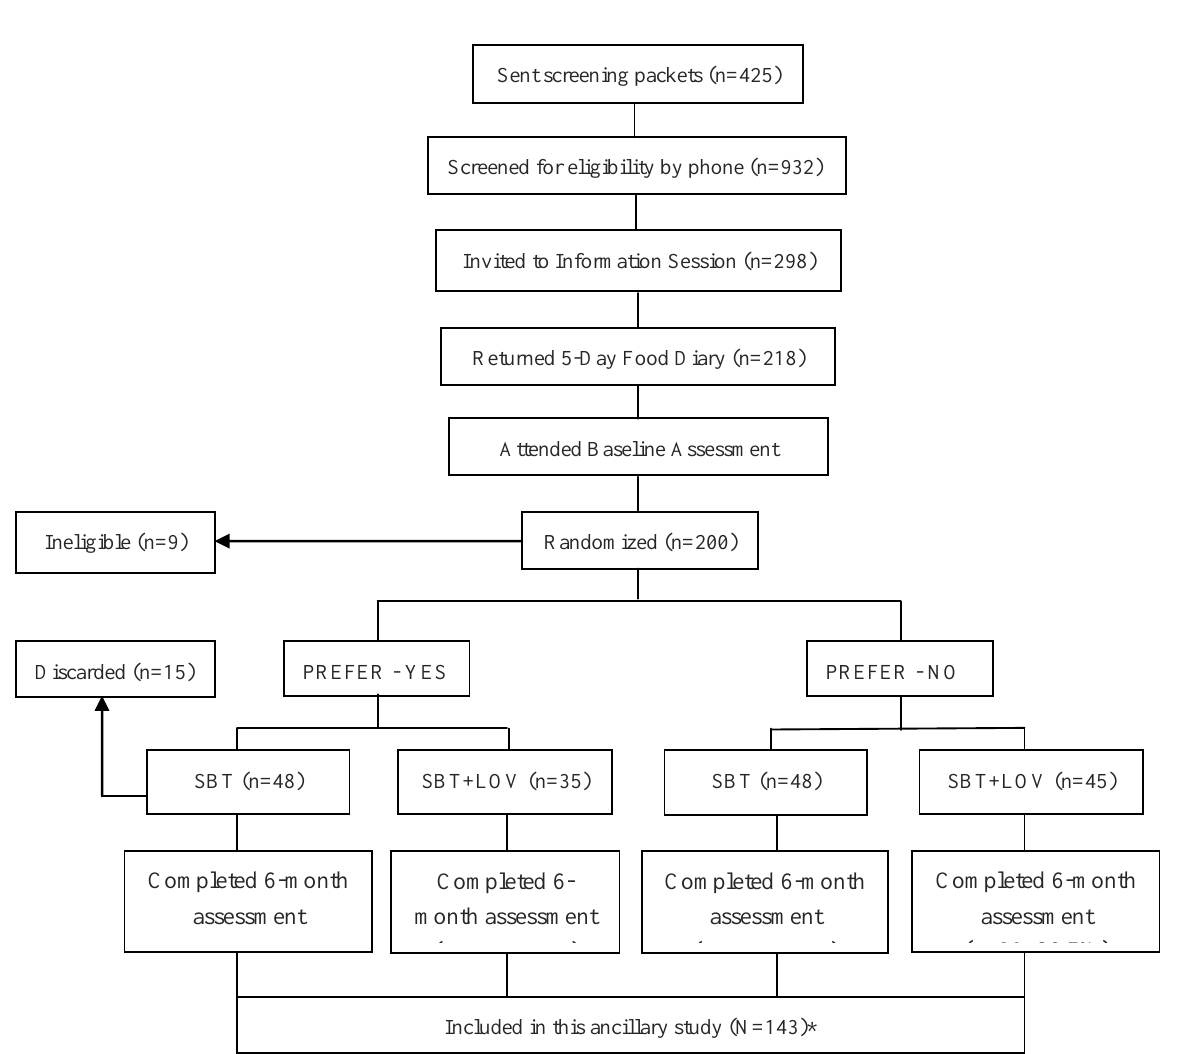
Figure 2. PREFER trial flowchart (included only 6-mo